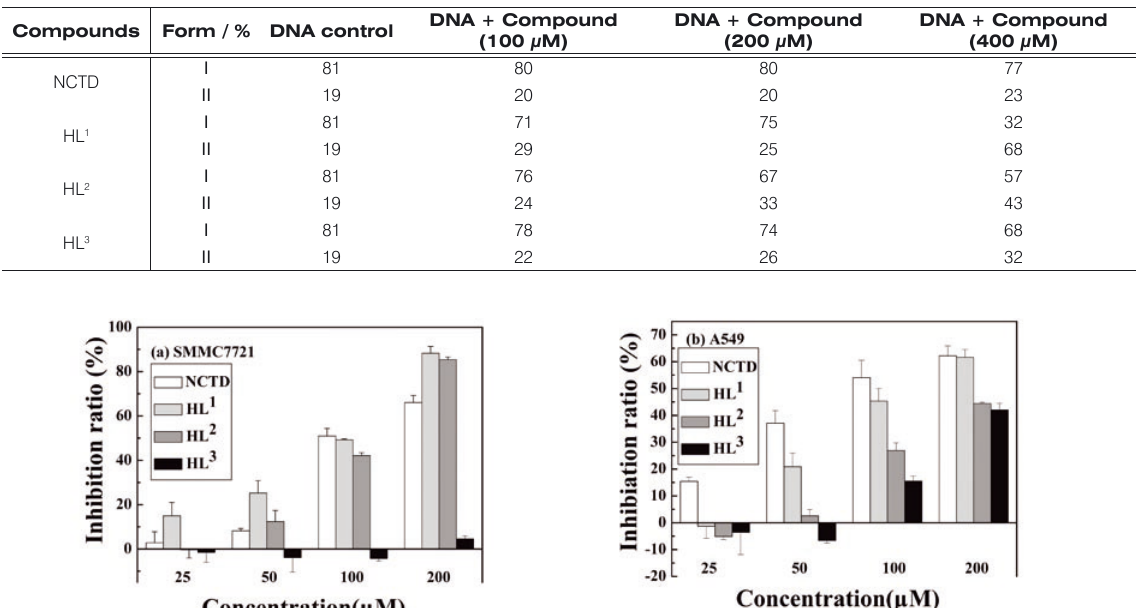
Table 1. Comparison of the pBR322 DNA cleavage efficiency at different concentrations of NCTD and HL. Compounds Form / % DNA control